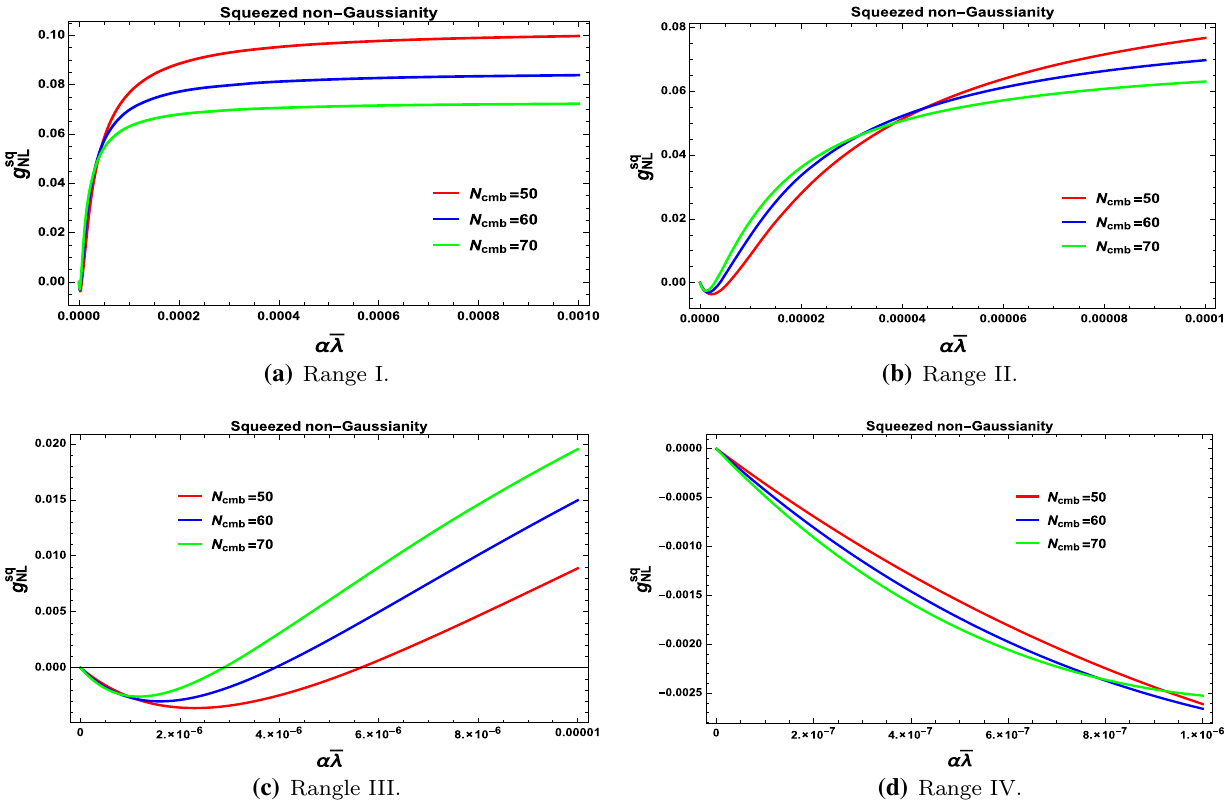
Fig. 32 Representative diagram for equilateral non-Gaussian three point amplitude vs. product of the parameters α ¯ λ in four different regions for = 50 ( red ), N = 60 ( blue ) and N = 70 ( green N cmb cmb cmb